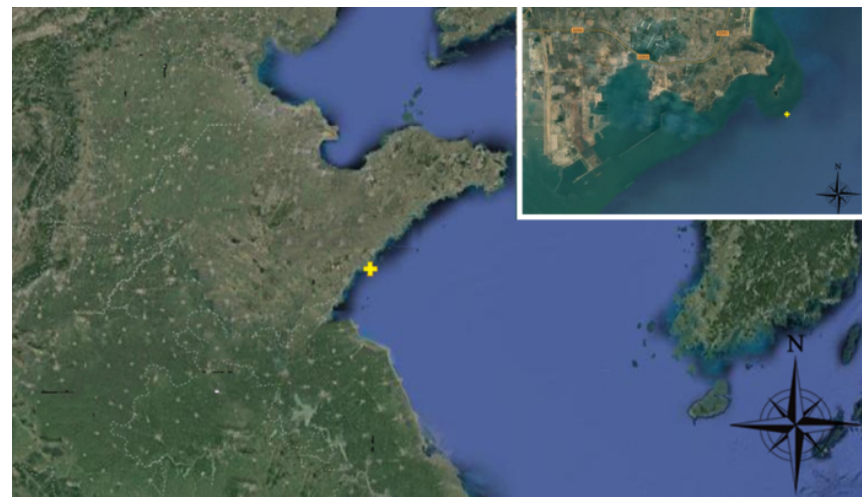
Figure 5. The location of Zhaitang Island tidal current test field in China East Sea.